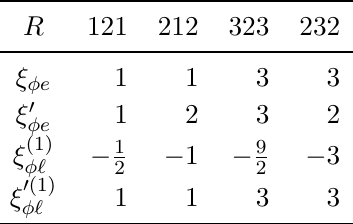
Table 1 . Representation-dependent SU(2) L factors relevant for C φe and C (1)